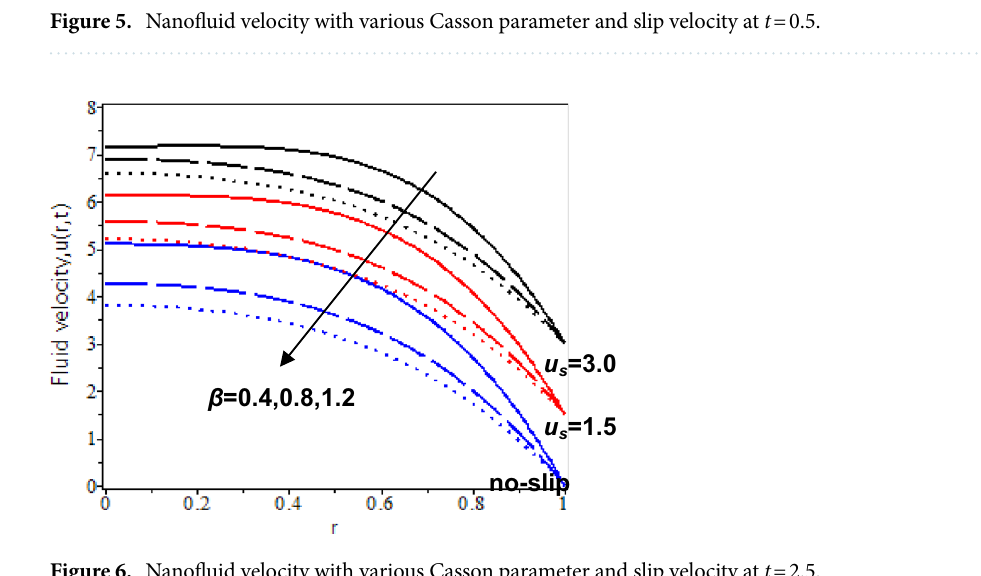
Figure 6. Nanofluid velocity with various Casson parameter and slip velocity at t = 2.5.